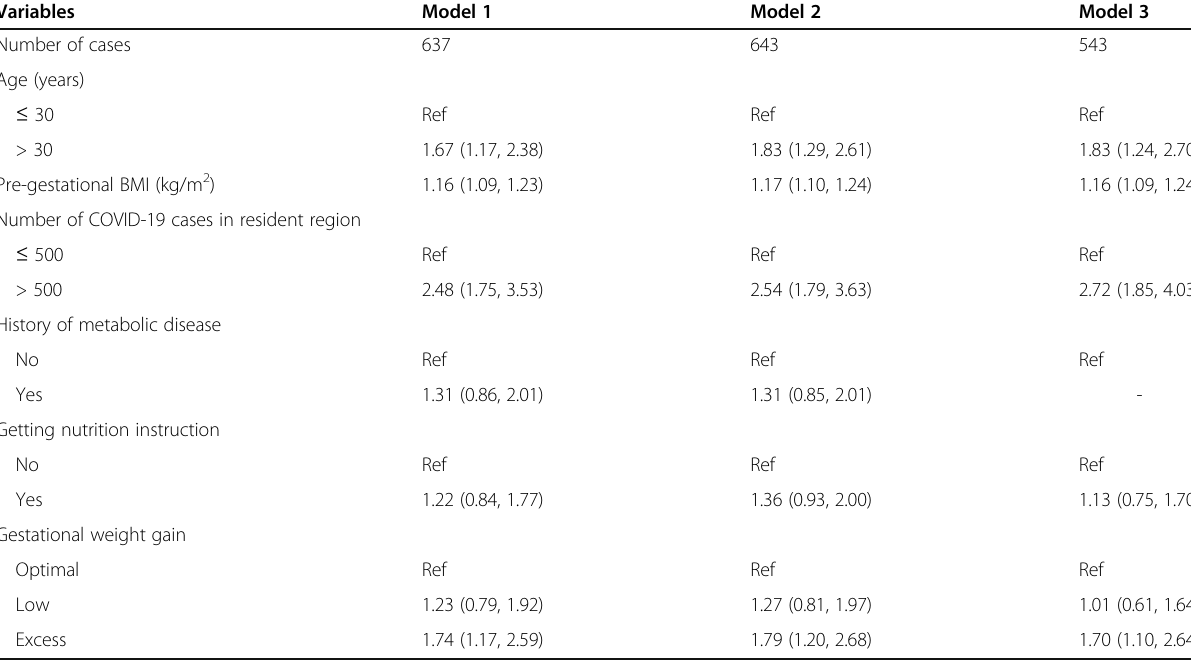
Table 4 Subgroup analysis of multivariate analysis on exploring associated factors of delivery mode